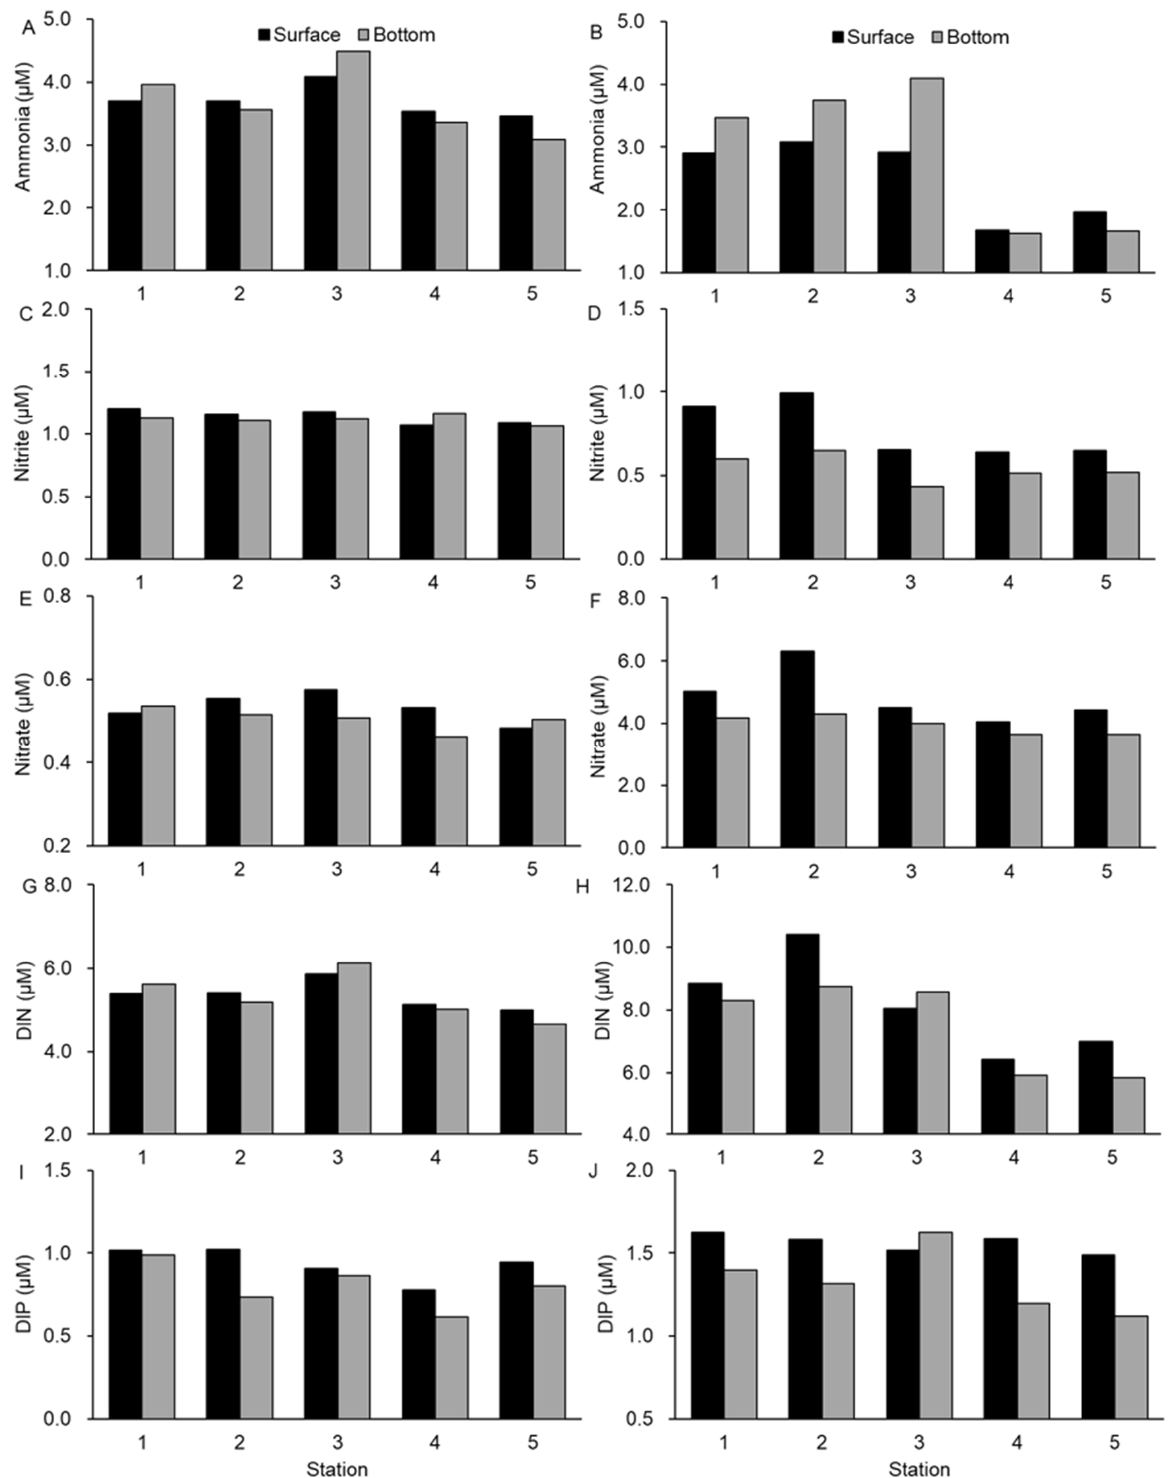
Figure 3. Dissolved inorganic nutrients ( µ M) in the study region. ( A ) Ammonia in May, ( B ) Ammonia in September, ( C ) Nitrite in May, ( D ) Nitrite in September, ( E ) Nitrate in May, ( F ) Nitrate in September, ( G ) Dissolved inorganic nitrogen (DIN; ammonia + nitrite + nitrate) in May, ( H ) DIN in September, ( I ) Dissolved inorganic phosphorous (DIP) in May, ( J ) DIP in September. Circles denote water quality in the surface water, and squares denote water quality in the bottom